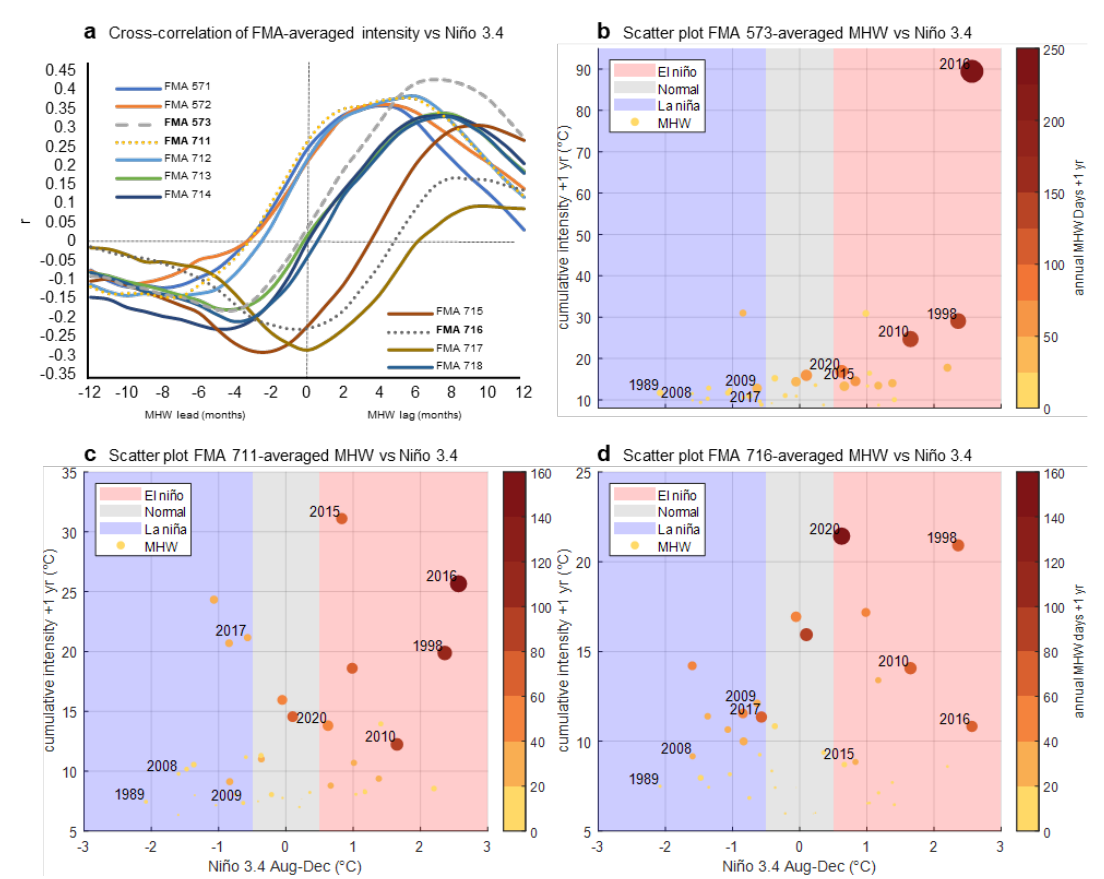
Figure 4. Cross–correlation between Niño 3.4 and FMA averaged MHWs ( a ), scatter plot between FMA573 ( b ), FMA 711 ( c ), FMA 716 ( d ), averaged MHWs vs. Niño 3.4. Blue shades indicate negative phase (La Niña), red shades indicate positive phase (El Niño), and grey shades indicate neutral